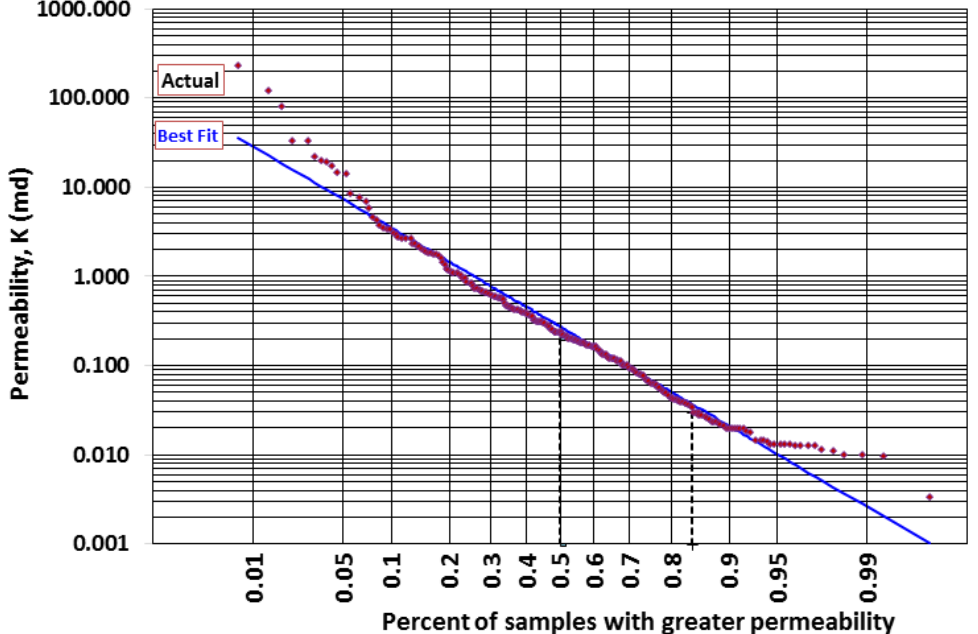
Figure 1. Permeability variation factor V DP forUpper Bahariya